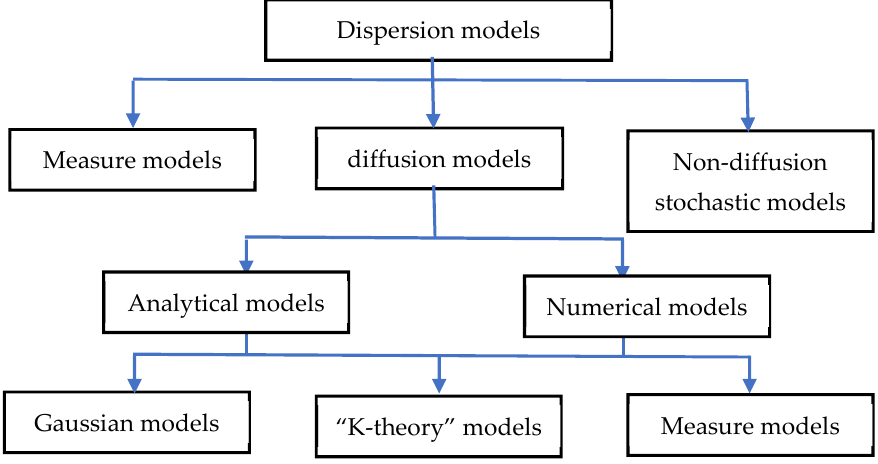
Figure 1. Division of dispersion models.